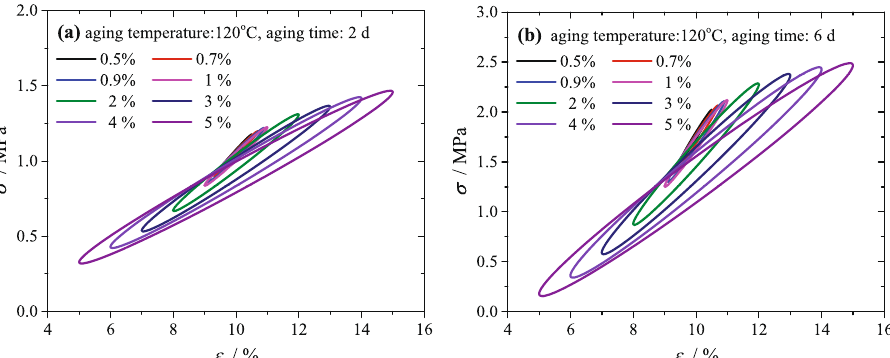
Fig. 5 Steady-state hysteresis loops. The hysteresis loops of the material aged at 120 ℃ for different periods of time: a 2 days and b 6 days. The curves are obtained under various dynamic strain amplitudes, i.e. 0.5%, 0.7%, 0.9%, 1%, 2%, 3%, 4% and 5%.